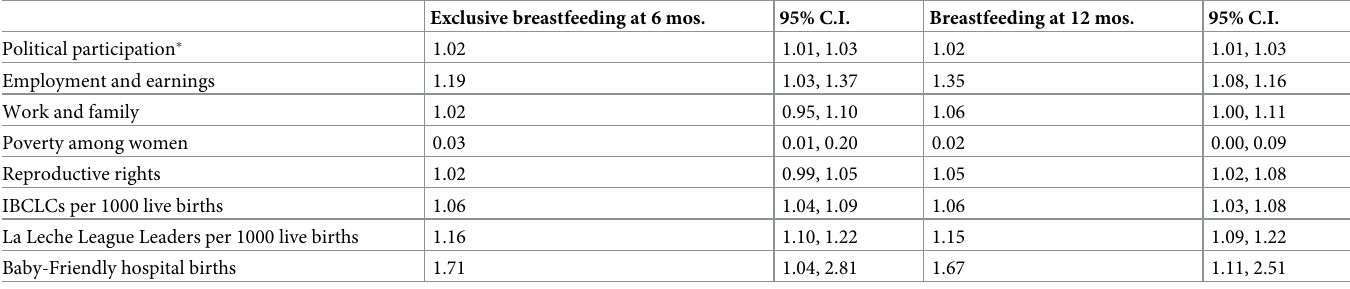
Table 1. Incidence rate ratios estimating bivariate associations between state-level status of women, breastfeeding support, and breastfeeding practices for births in the U.S. in 2015 (n = 51). Exclusive breastfeeding at 6 mos. 95% C.I. Breastfeeding at 12 mos. 95%